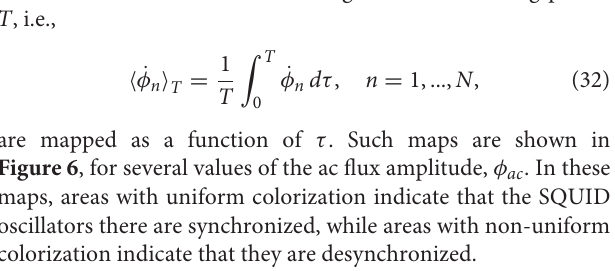
time-derivatives of the fluxes, averaged over the driving period T , i.e.,